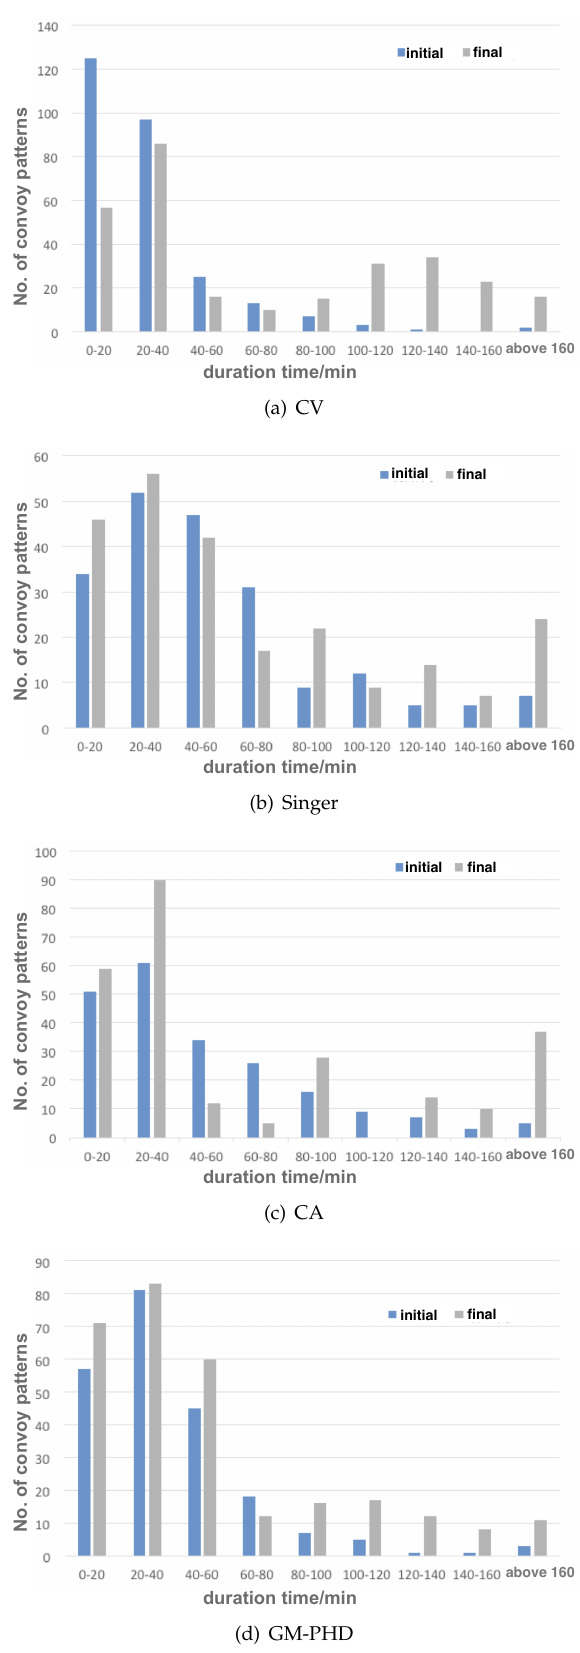
Figure 13. Distributions of duration time for the convoy patterns before and after evolution (with